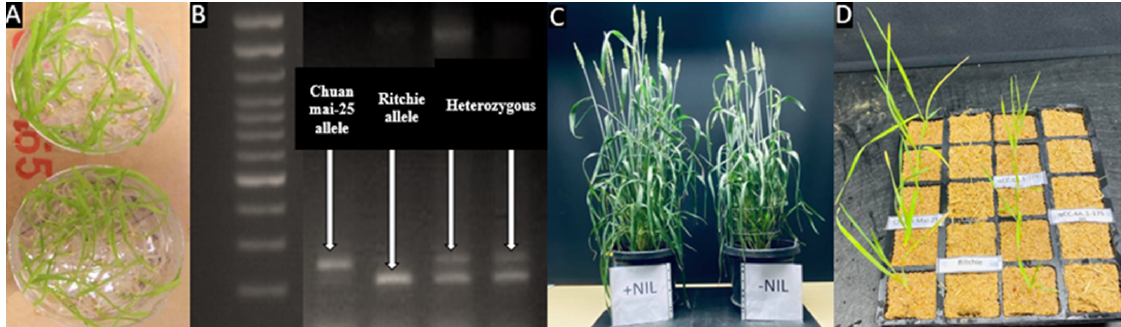
Figure 1. Procedures involved in NIL development. ( A ) Seedlings raised using a fast generation-cycling system (FGCS): the extracted embryos were germinated, and the plantlets grown in tissue culture media on Petri dishes. ( B ) A molecular marker was used to select the homozygous resistant (Chuan Mai 25 allele) and homozygous susceptible (Ritchie allele) lines in the F 8 generation while the heterozygous types were selected up to the F 7 generation. ( C ) One NIL pair (one line with Chuan Mai 25 allele ‘+’and another line with Ritchie allele ‘ − ’) in the F 8 generation differed in growth. ( D ) Columns from left to right: resistant parent Chuan Mai 25 seedlings, susceptible parent Ritchie seedlings (all dead), resistant isolines of a NIL pair ‘17’, and susceptible isolines of pair ‘17’ (all dead).